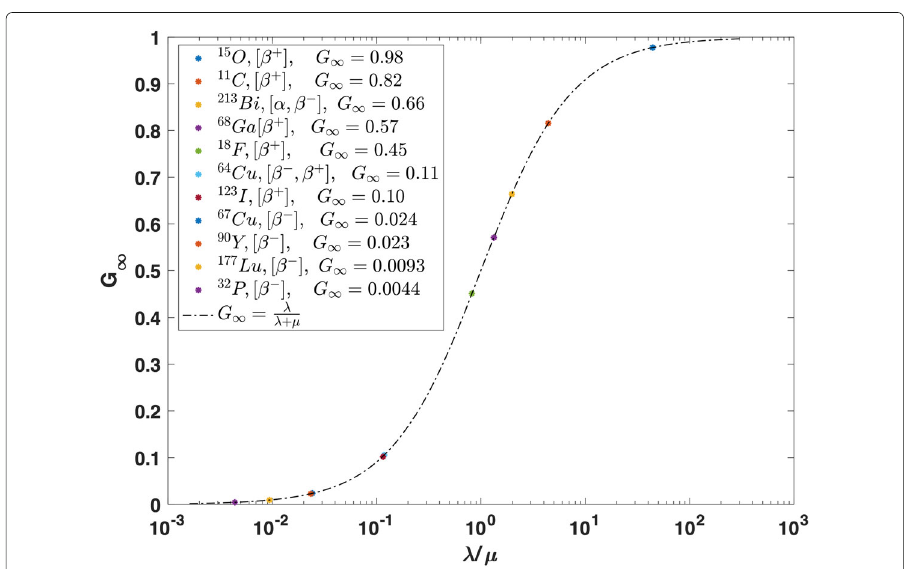
Fig. 9 G ∞ for common medical